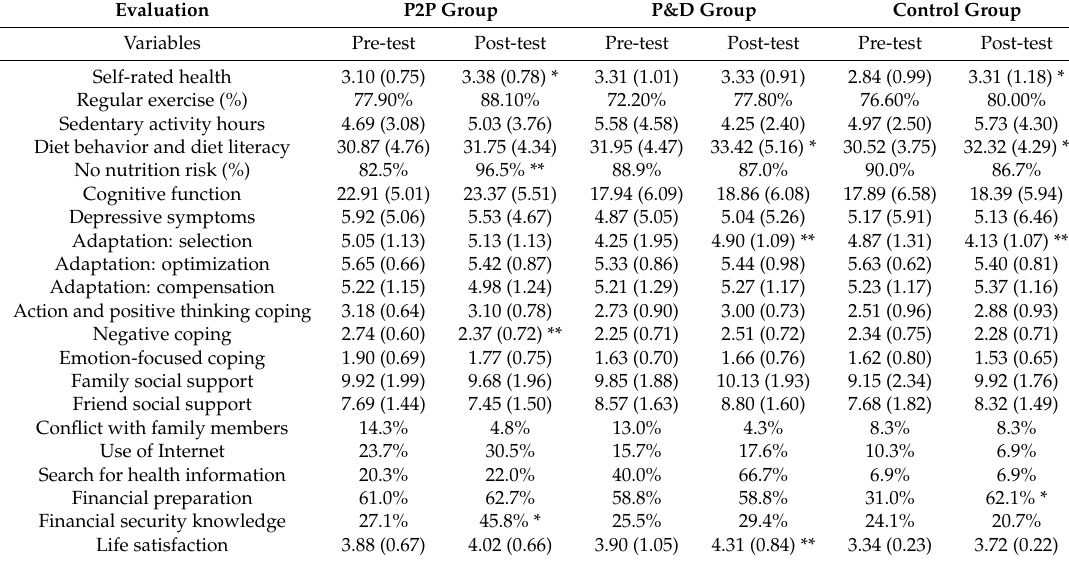
Table 2. Evaluation of the outcome variables before and after intervention within three